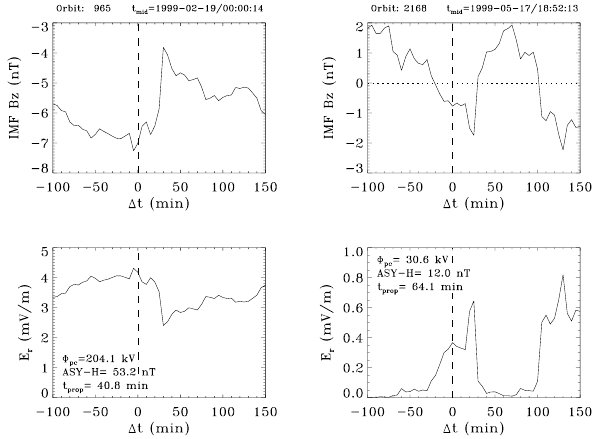
Fig. 3. Solar wind-magnetosphere correlation with (a) IMF B z , and (b) reconnection electric field. The corresponding filtered correla- tion coefficients are shown in (c) and (d) , where the horizontal line marks r = 0 . 50. Time resolution is 5 min. The maximum correla- tion coefficients and corresponding time lag 1t are shown on each